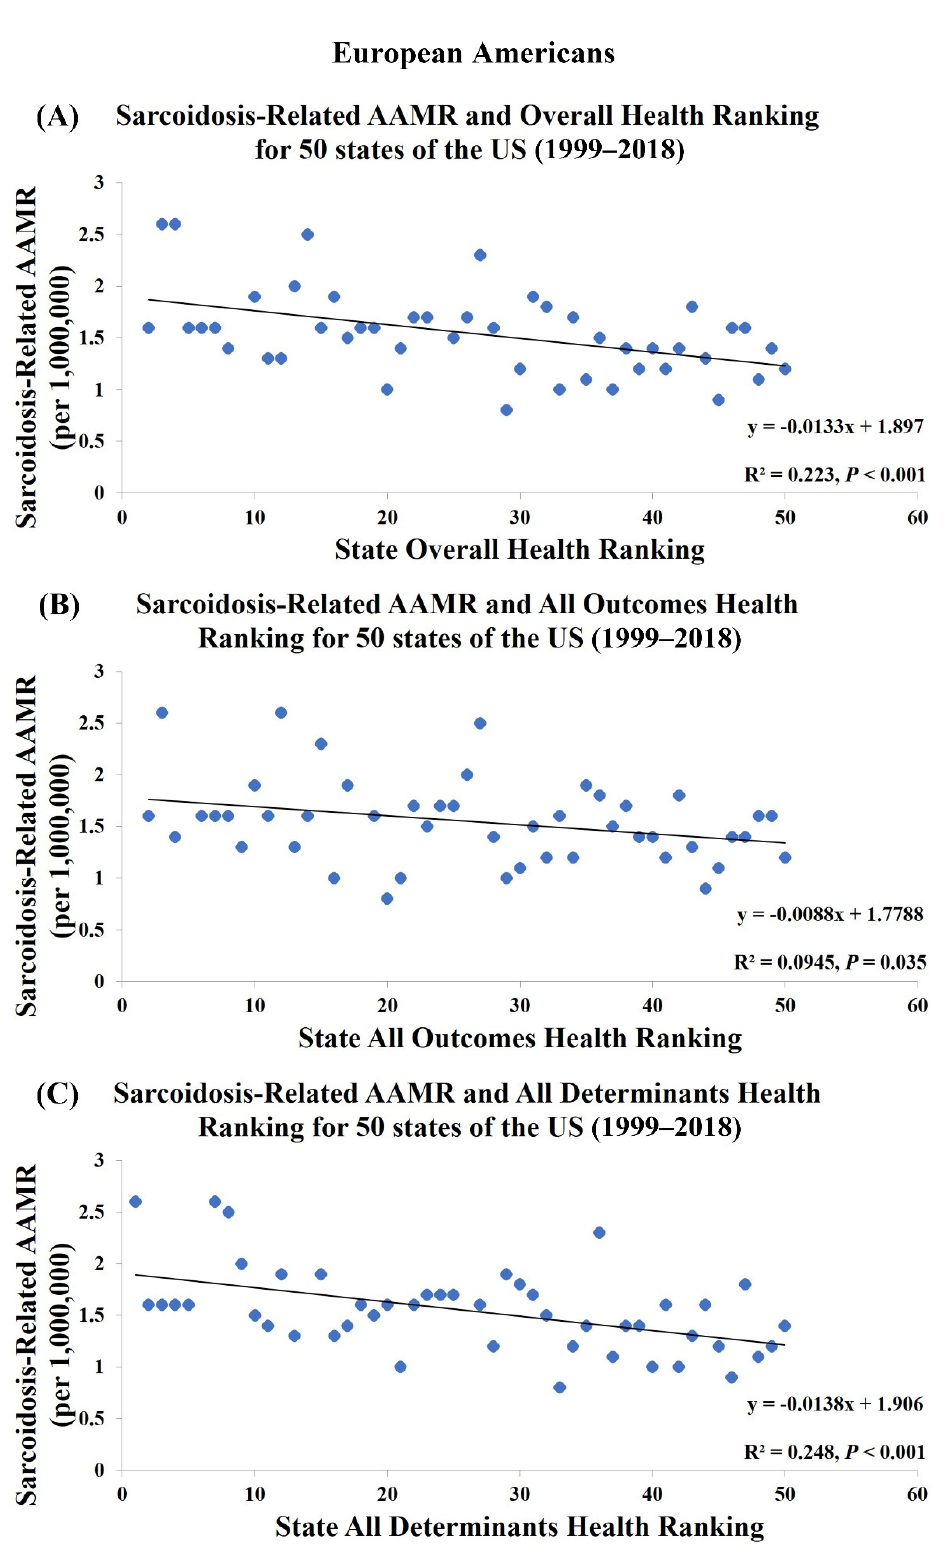
Figure 3. Sarcoidosis-Related AAMR in European Americans is significantly associated with ( A ) Overall Health Rankings, ( B ) All Outcomes Health Rankings, and ( C ) All Determinants Health Rankings.